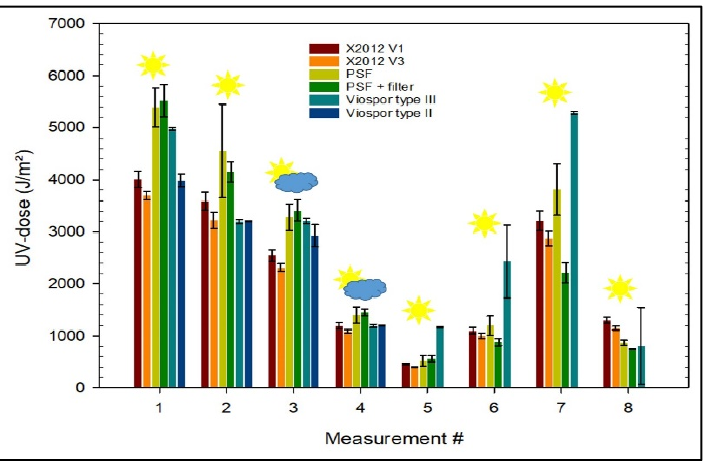
Figure 2. Chart of measurement data subdivided into measurement scenarios and dosimeter types. Incident angle of solar radiation: 0° for measurements number 1, 3–5; 30° for measurement number 2; 110° for measurement number 6; 60° for measurement number 7; 85° for measurement number 8.